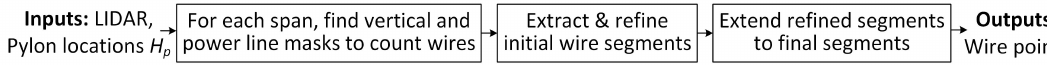
Figure 11. The work flow for extracting wire